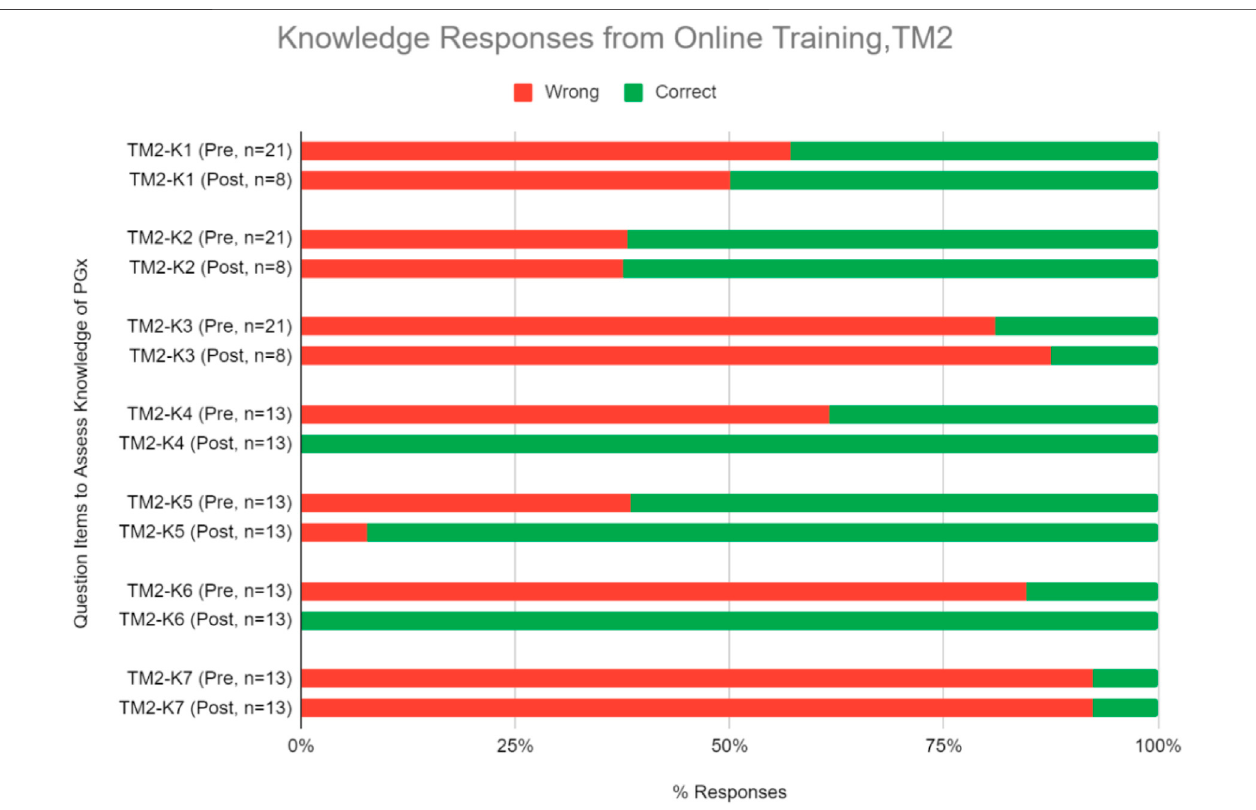
FIGURE 6 | Percent of correct or wrong responses to knowledge questions obtained during pre-and post-PGx online training TM2. Two questions in the knowledge section (TM2-K4 and TM2-K6) received 100% of respondents answering correctly in the post-training assessment.